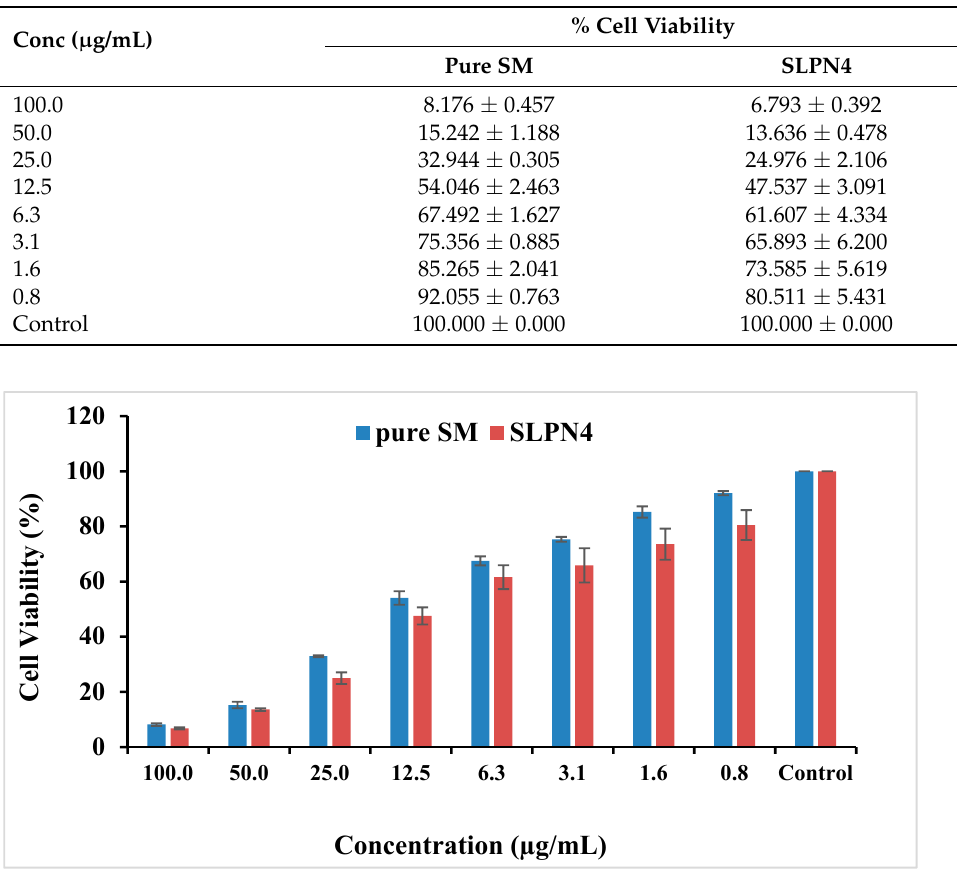
Figure 8. Cytotoxicity of pure SM and SLPN4 after 48 h incubation with MCF-7 cells at concentrations 0.8–100 µg/mL.